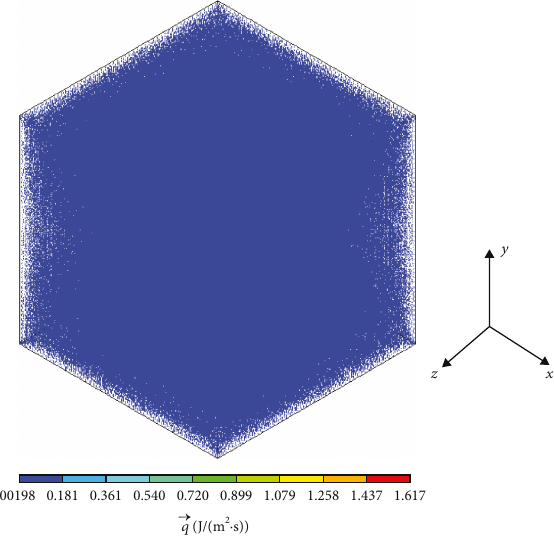
Figure 27: Heat fl ow vector of the carbonization model microsphere.